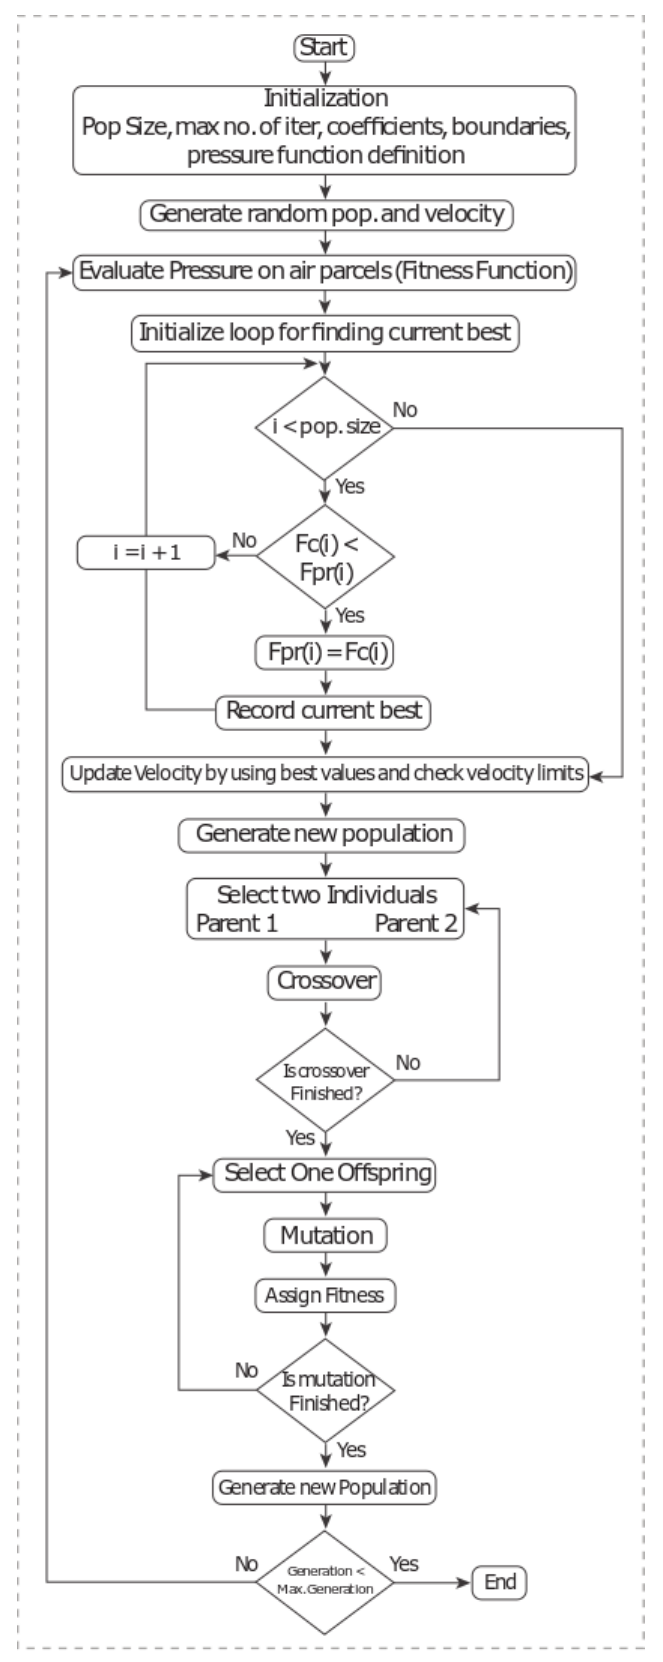
Figure 2. Flowchart diagram of the overall energy management system